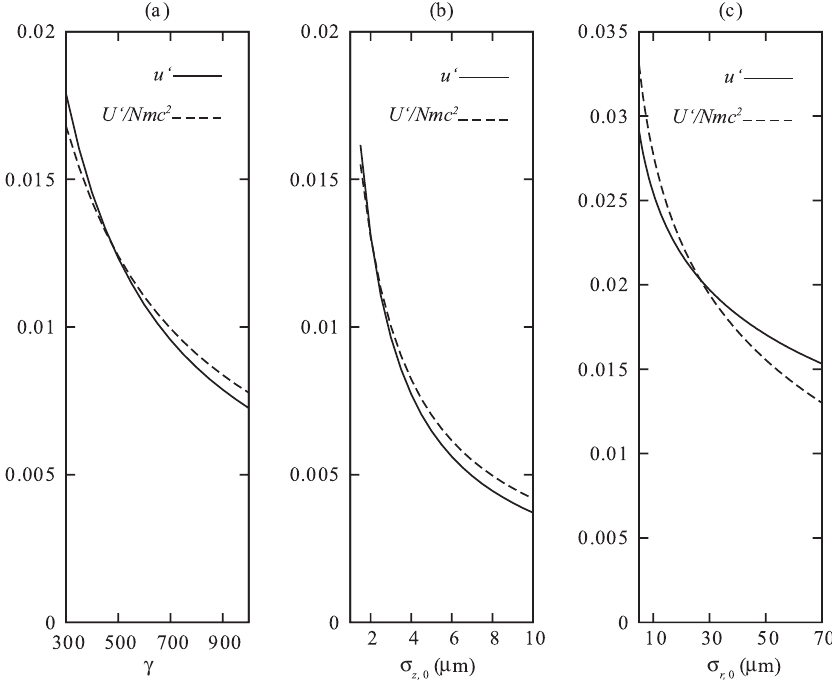
FIG. 4. Comparison between u 0 [Eq. (13)] (solid curves) and U 0 =Nmc 2 [Eq. (11)] with M ¼ 3000 (dashed curves) as a function of , and (c) initial transverse size (cid:5) r; (a) energy, (b) initial longitudinal length (cid:5) z; 0 ¼ 42 (cid:2) m in (a) and (b), and (cid:3) ¼ 300 in (b) and (a) and (c), (cid:5) r; 0